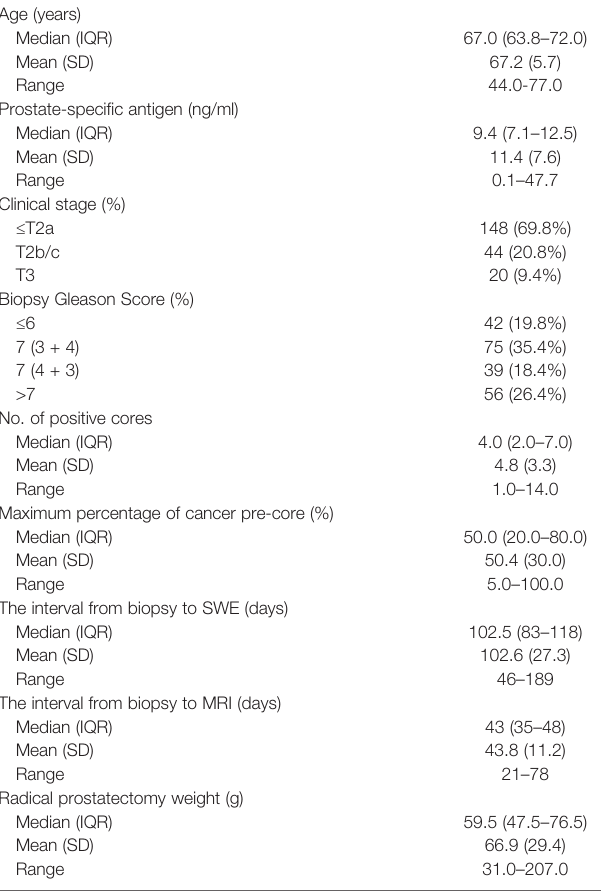
The PIRADS score at mpMRI failed to maintain the same TABLE 1 | Patient